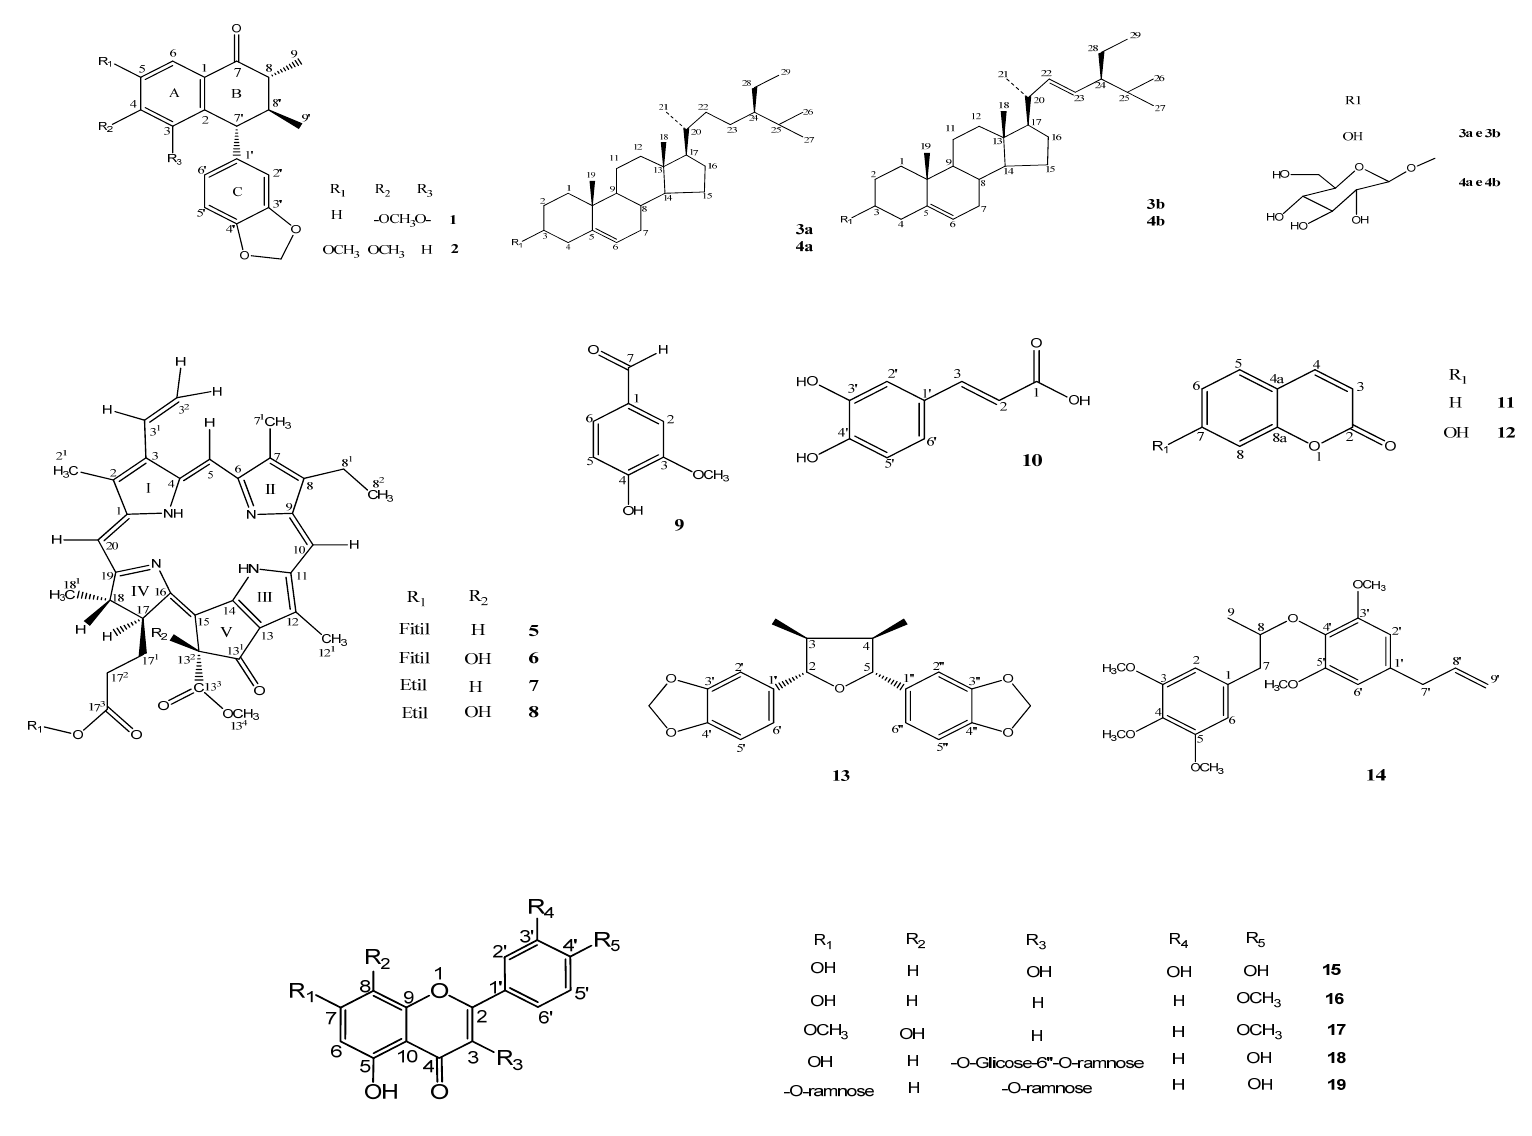
Figure 2. Constituents isolated from Cordia exaltata